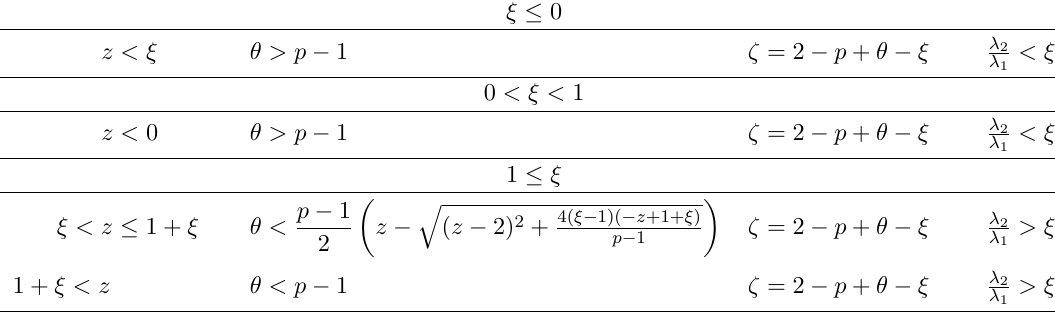
Table 3. Parameter range: Class I-i, V 0 > 0.